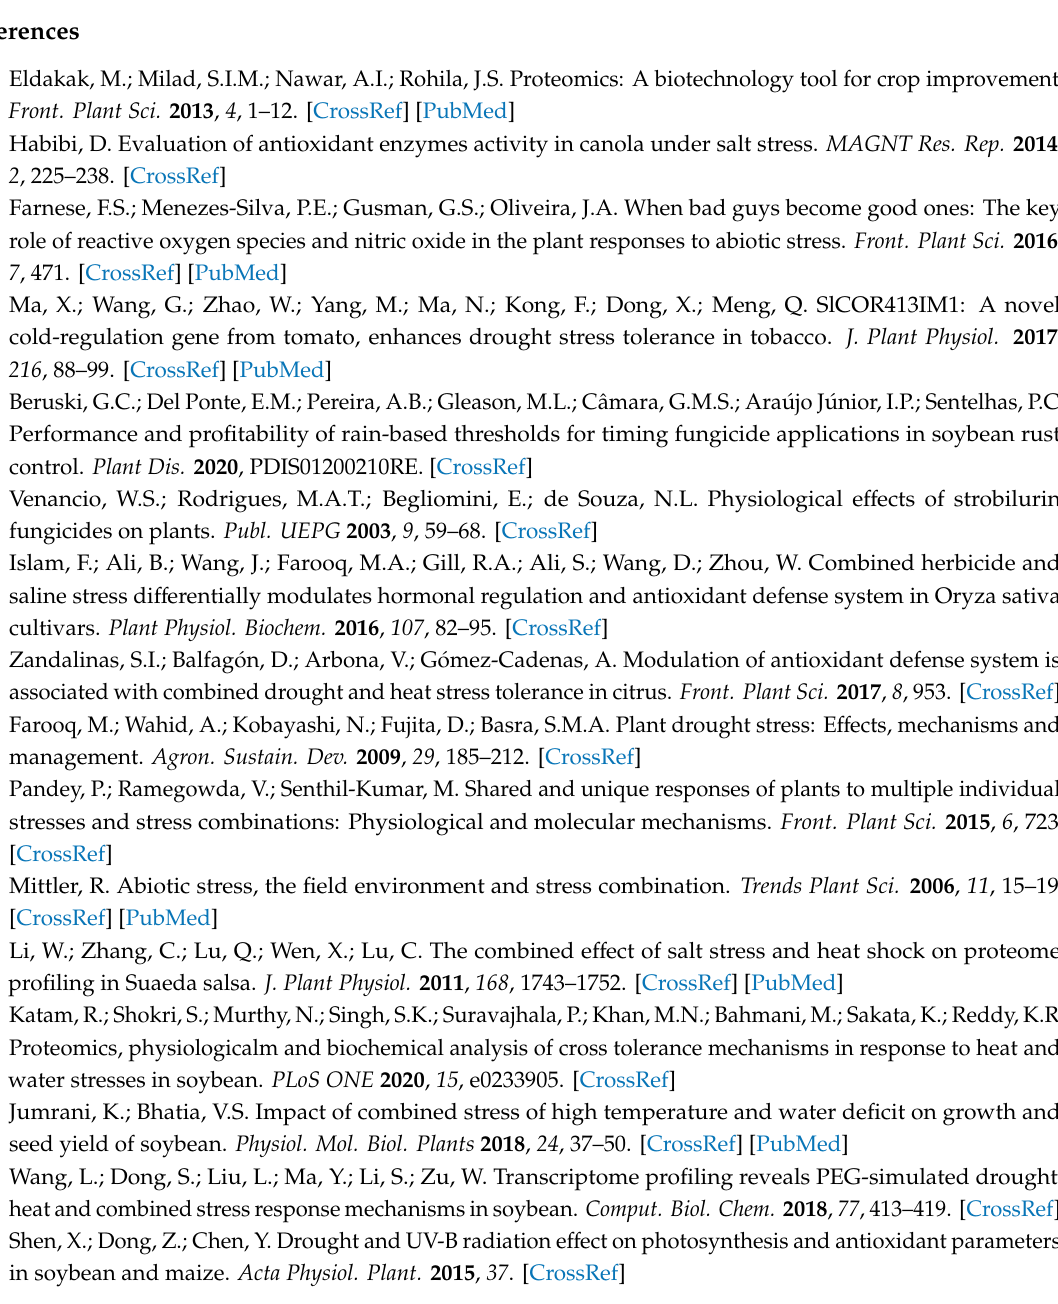
Figure S1: Soil retention characteristic